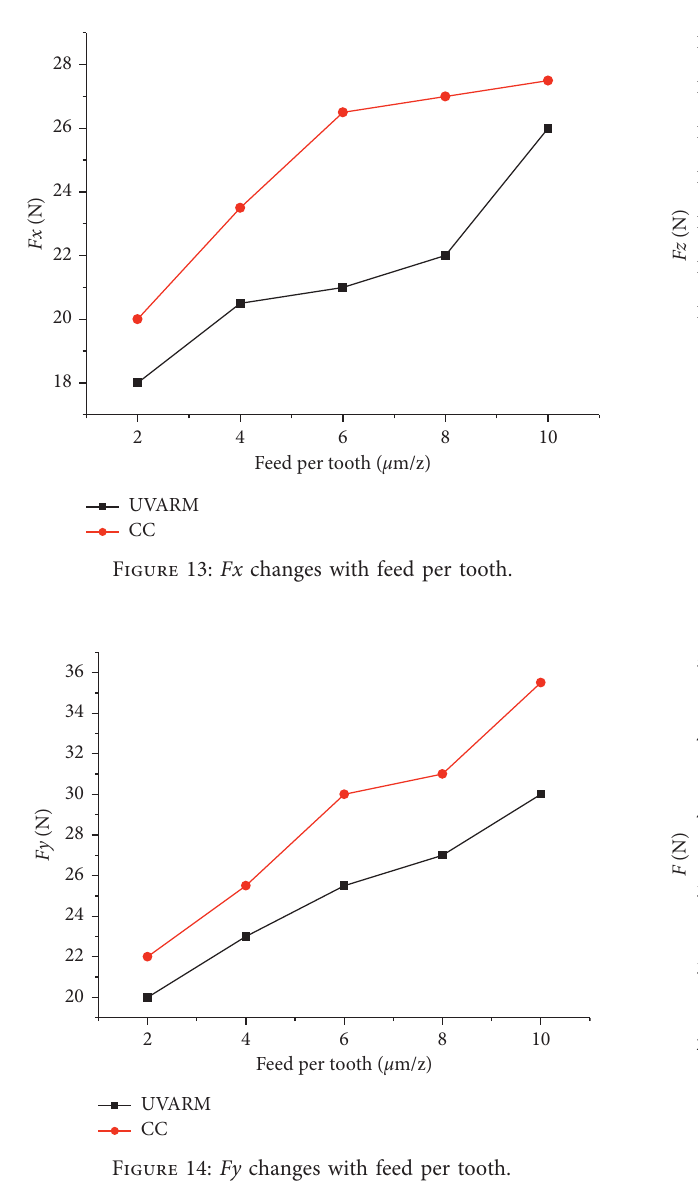
Figure 16: F changes with feed per